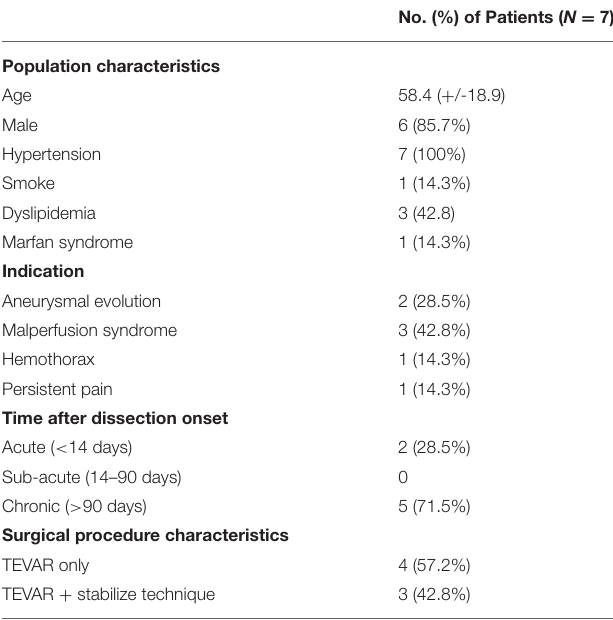
TABLE 1 | Baseline clinical and procedural characteristics of patients with type B aortic dissection and indication of endovascular treatment. No. (%) of Patients ( N =